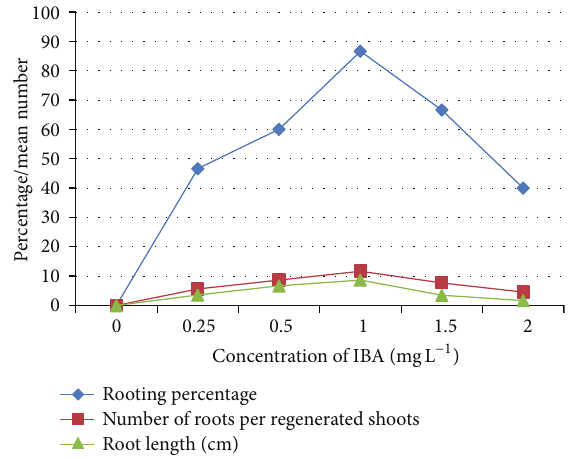
Figure 3: Effect of IBA on in vitro rooting of A. lanata regenerated shoots after 28 days. Data represented mean of three replicates, each with 15